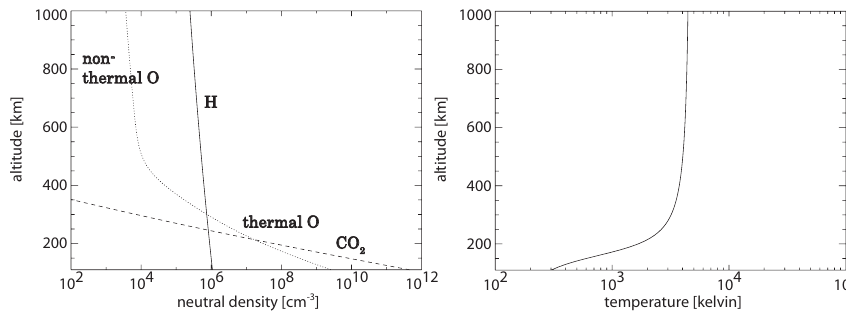
Fig. 1. The neutral atmosphere profiles (left) and the temperature profile (right) used in the present model.